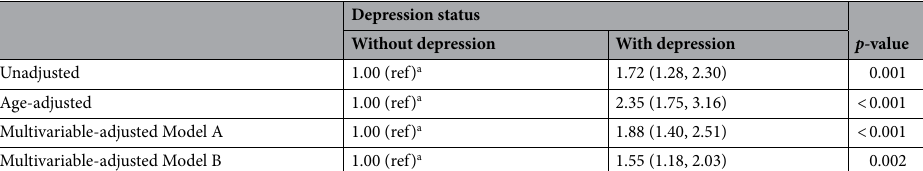
Table 3. Hazard ratio (95% CI) for all-cause mortality according to depression status. Data are representative of non-institutionalized American population. Model A is adjusted by age, sex, race/ethnicity, annual household income, and educational level. Model B is additionally adjusted by alcohol consumption, smoking status, BMI, arterial hypertension, dyslipidemia, and diabetes. With depression: scored ≥ 10 in PHQ-9; Without depression: scored < 10 in PHQ-9. a Significant differences between without-depression and with-depression groups.